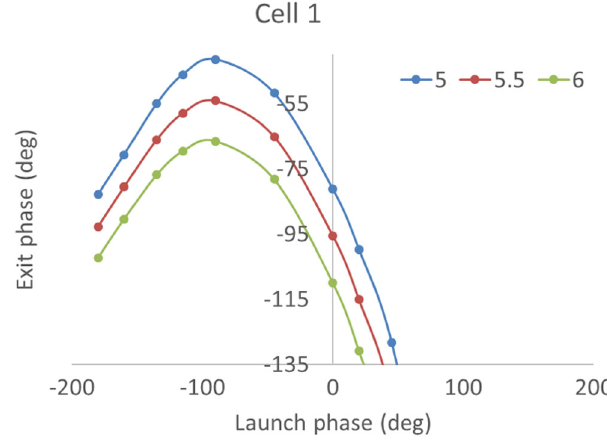
FIG. 3. Arrival phase at the exit of the first cell as a function of the electron launch phase from the cathode, for differing lengths of the first cell.